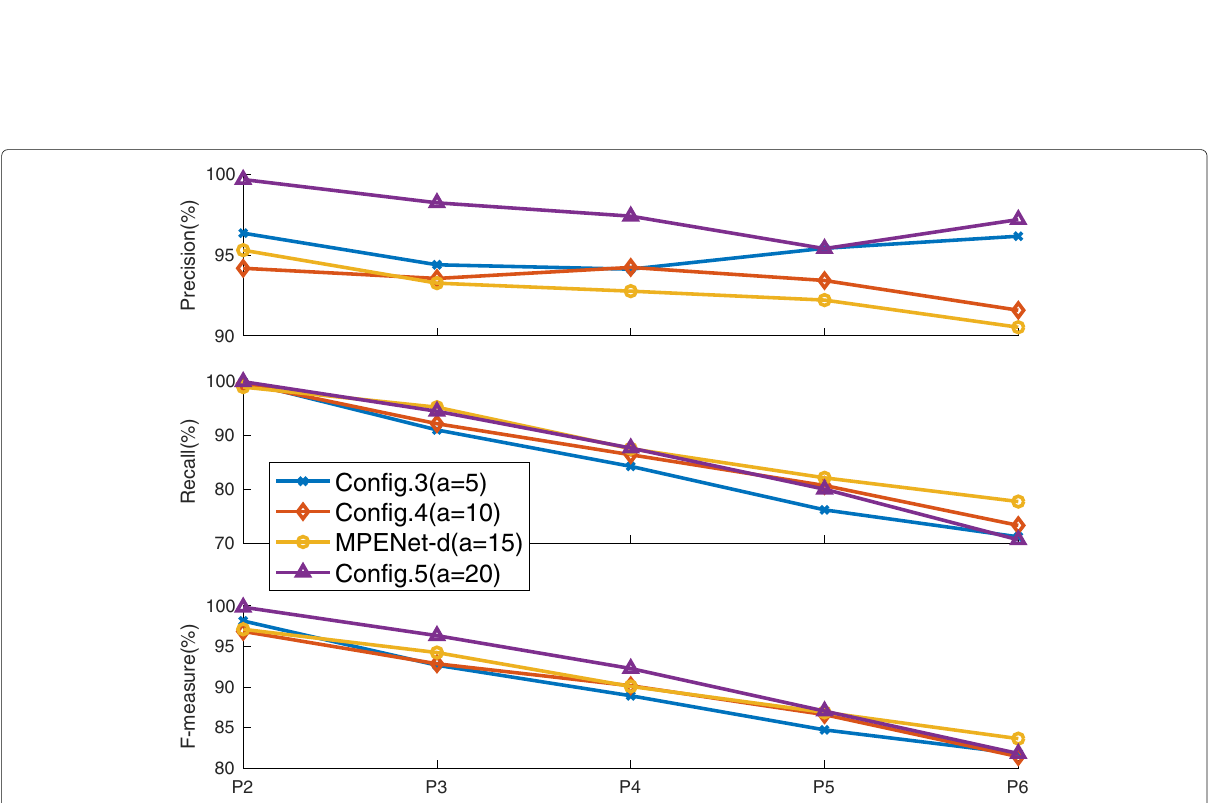
Fig. 9 Atom number comparison results. Precision, Recall, and F-measure are shown in three subplots from top to bottom, respectively, where y axis indicates percentage value and x axis indicates polyphony level. Three subplots share same